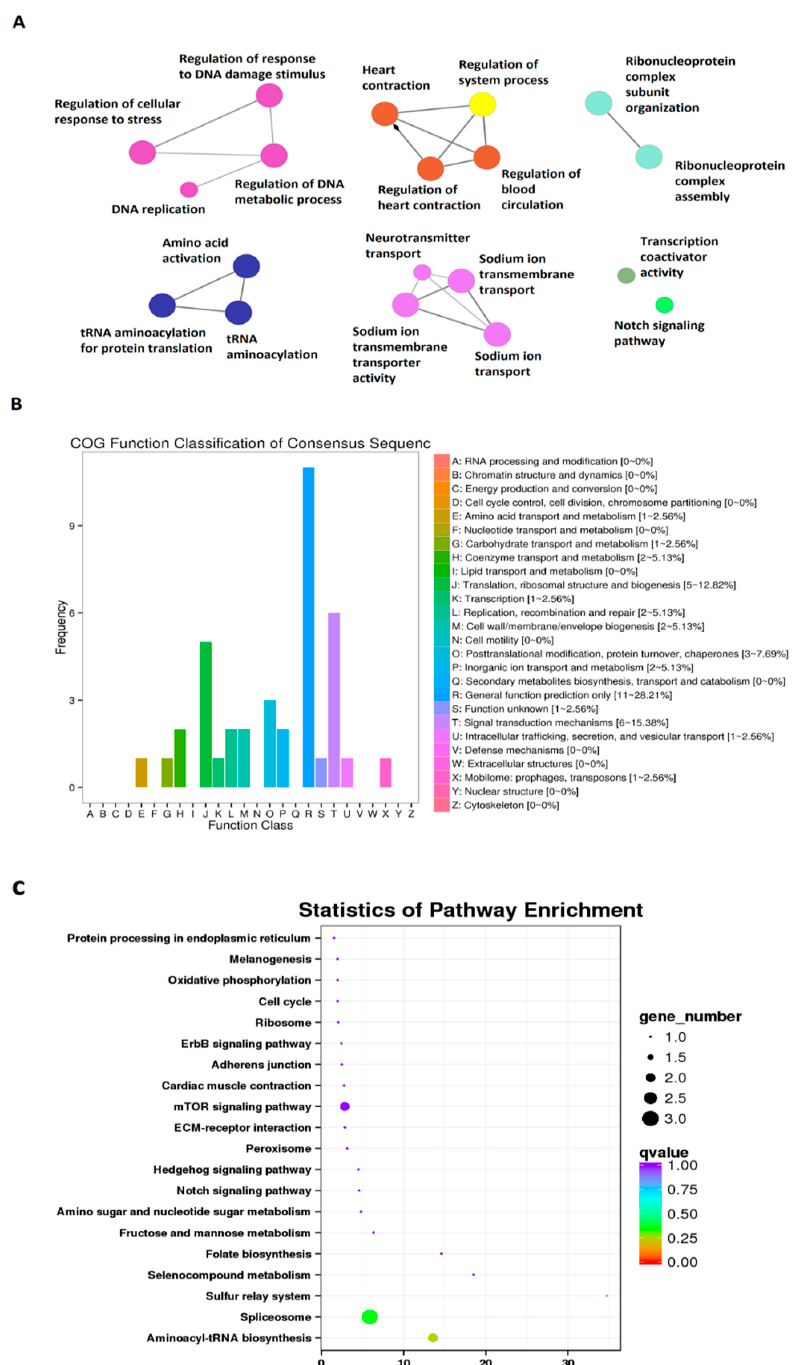
Figure 2. GO, COG, and KEGG analyses of circadianly expressed larval zebrafish lncRNAs under the DD condition. ( A ) GO annotation of the zebrafish larval lncRNAs under the DD condition revealed their potential involvement in several biological processes, such as nuclear receptor transcription coactivator activity, regulation of response to DNA damage stimulus, and regulation of DNA metabolic process. ( B ) COG functional classification of circadianly expressed larval zebrafish lncRNAs under the DD condition. ( C ) KEGG pathway enrichment analysis of the circadianly ex- pressed larval zebrafish lncRNAs under the DD condition.